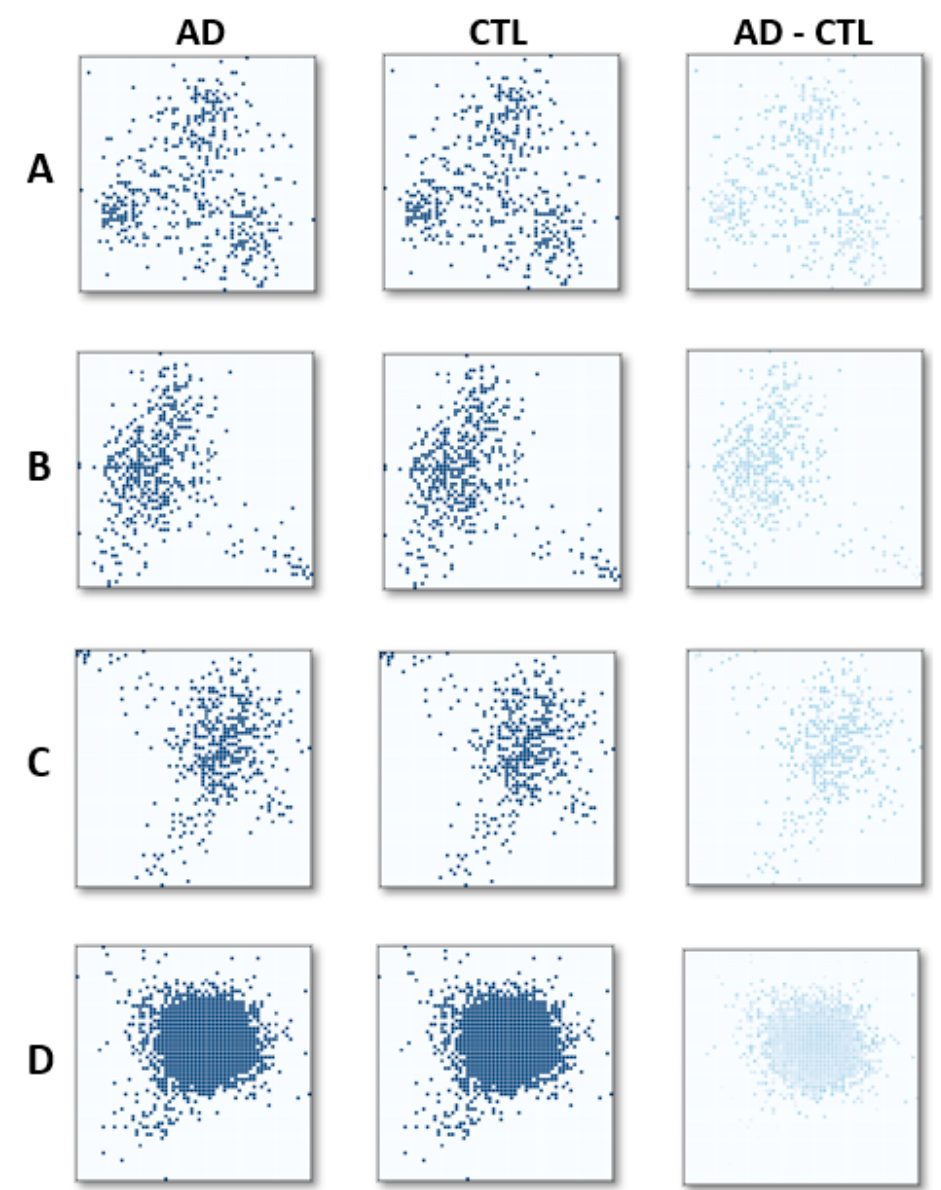
Figure 4. Mean intensity images for AD samples (first column); CTL samples (second column); and the difference in average images (third column) for the sets with 3 ( A ), 13 ( B ), and 17 ( C ) categories from the 488 genes selected, ( D ) with 11.168 common genes in the datasets unselected.